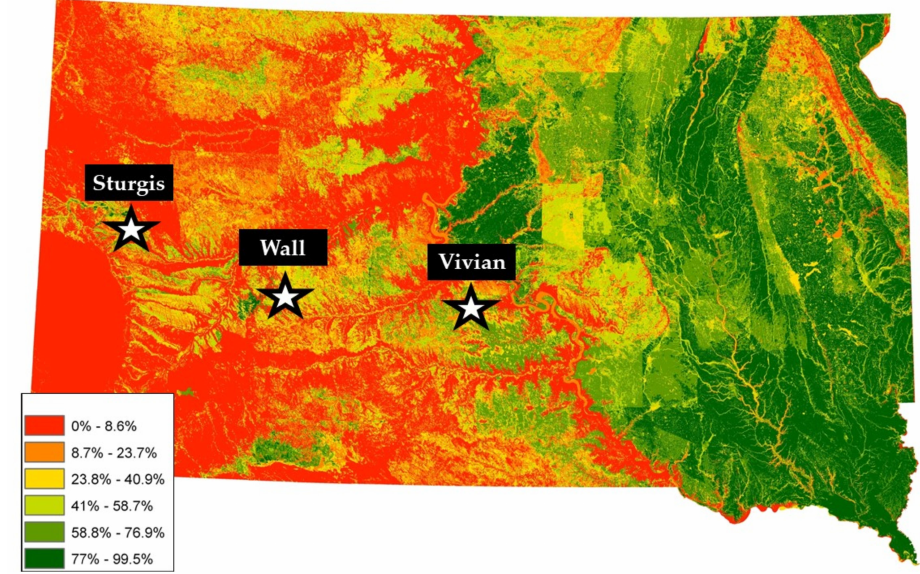
Figure 1. Study locations in South Dakota on a map depicting predicted cropland intensities by soil units in 2017 as proposed by the United States Department of Agriculture